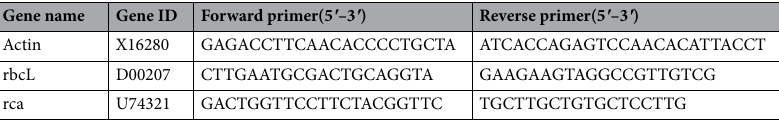
Table 2. Sequences of primers for real-time quantitative